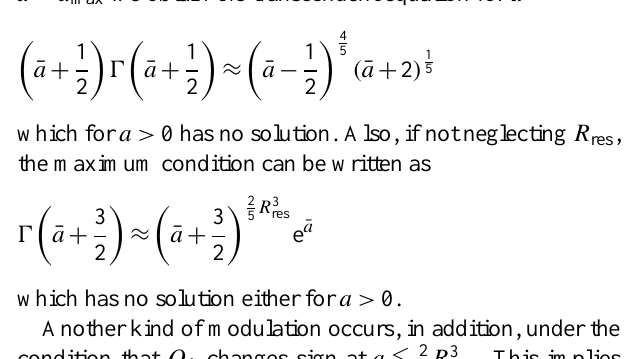
Fig. 6. Illustration of the widening of the loss cone by shifting the lower energy particles. The original Maxwellian is shown as a thin line. Cyclotron absorption (cf. Fig. 4) of the part of the distribution inside the maximum resonant radius R max flattens the distribution. Shift of the loss cone may either flatten or steepen the loss cone gradient a .